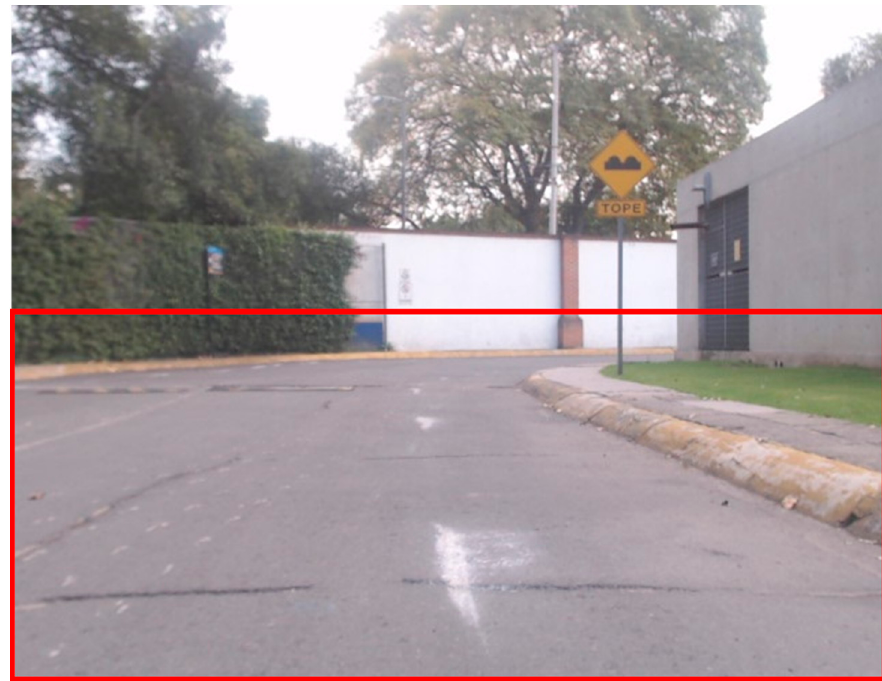
Figure 8. Image acquired and area of interest.